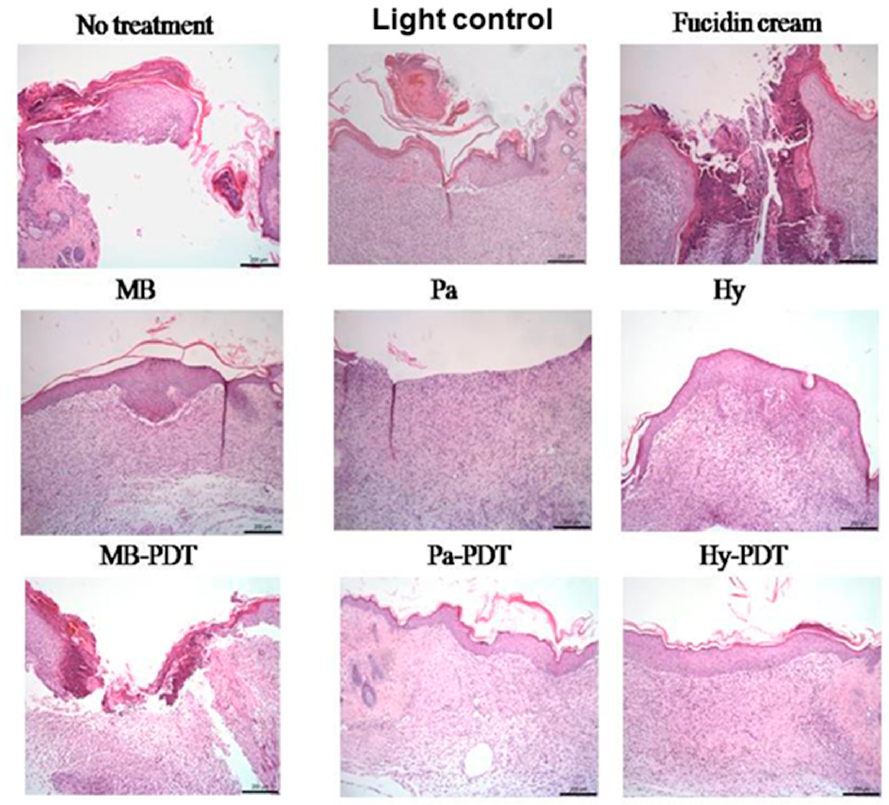
Figure 10. Representative wound section with haematoxylin and eosin stained and examined at × 100 magnification. Scale bar, 200 µm.